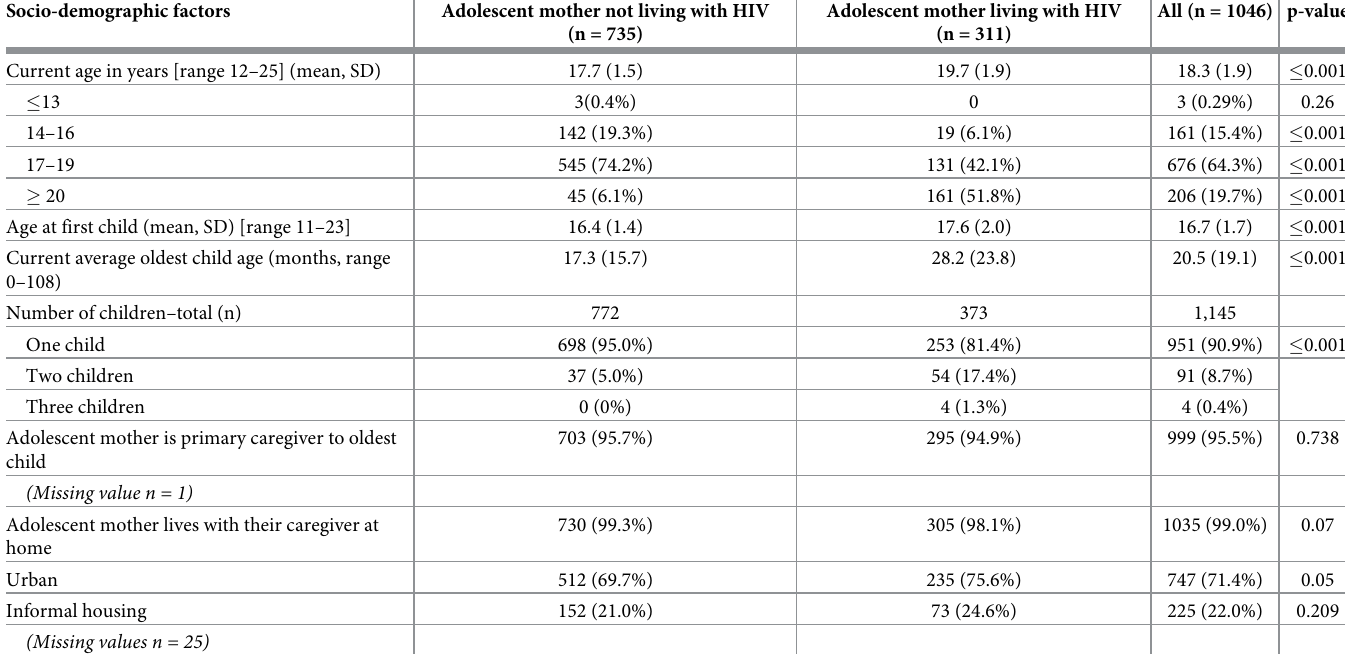
Table 1. Baseline